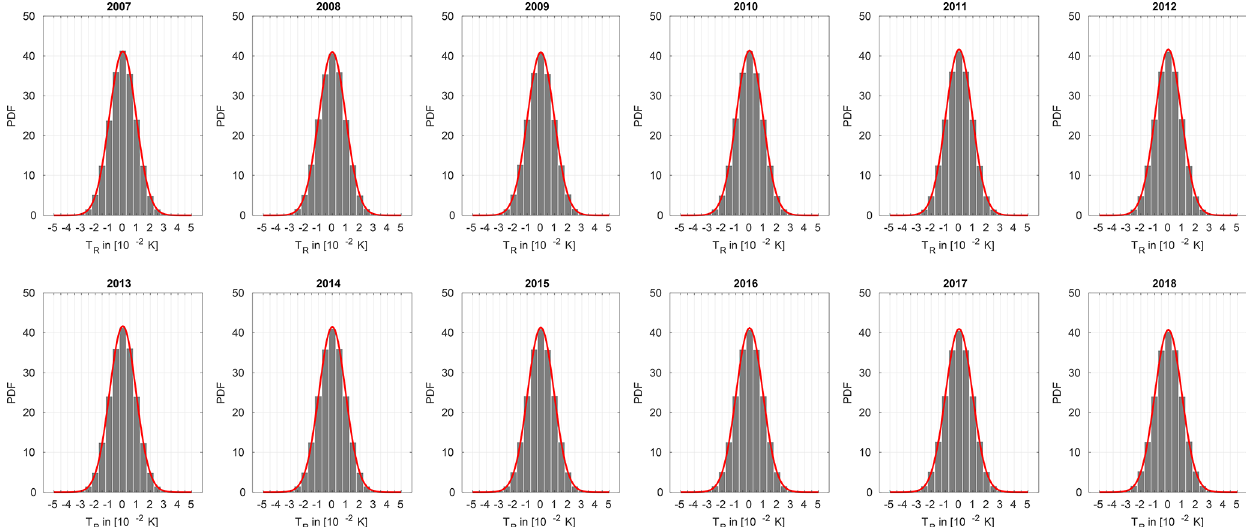
Figure 2. Yearly averaged histograms of the MIAWARA residuals (difference between measured difference spectrum and modeled spectrum) as residuum brightness temperature fluctuations T R in 10 − 2 K within the frequency range of 22.195 to 22 . 275GHz (80MHz bandwidth) from 2007 to 2018, showing the evolution of the PDF (probability density function). The red curve is the fit of the corresponding normal distribution. The chosen bin width is 5 × 10 − 3 K.